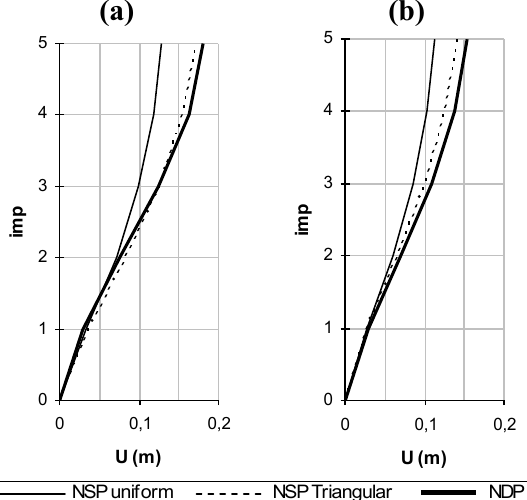
Figure 5. ( a ) Storey Displacement Comparison at collapse for in plan directions 0°; ( b ) at 90°.